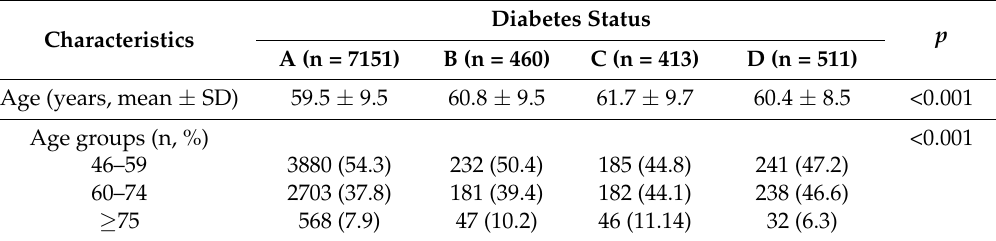
Table 1. Sociodemographic and health characteristics of the full study